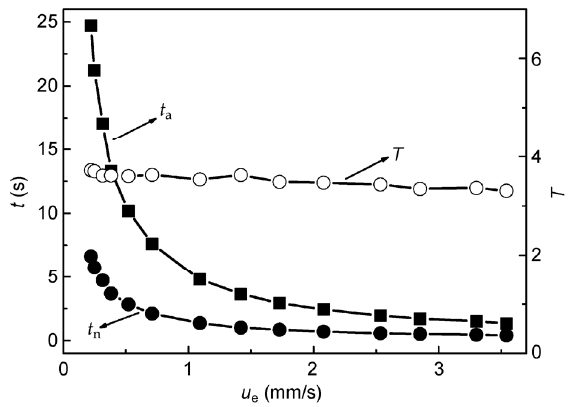
Fig. 11 Variations of t n , t a , and T with entrainment speed, 5P4E, w = 30 N, D ini = 1020 μ